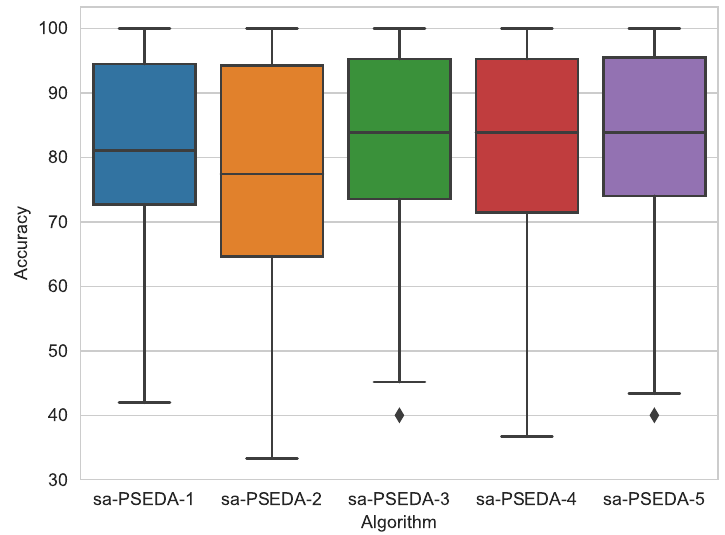
Figure 1. Box plots for sa-PSEDA equipped with the five fitness functions under study. Table 4. Average accuracy ± standard deviation and statistical analysis [42] for sa-PSEDA- ψ 5 against